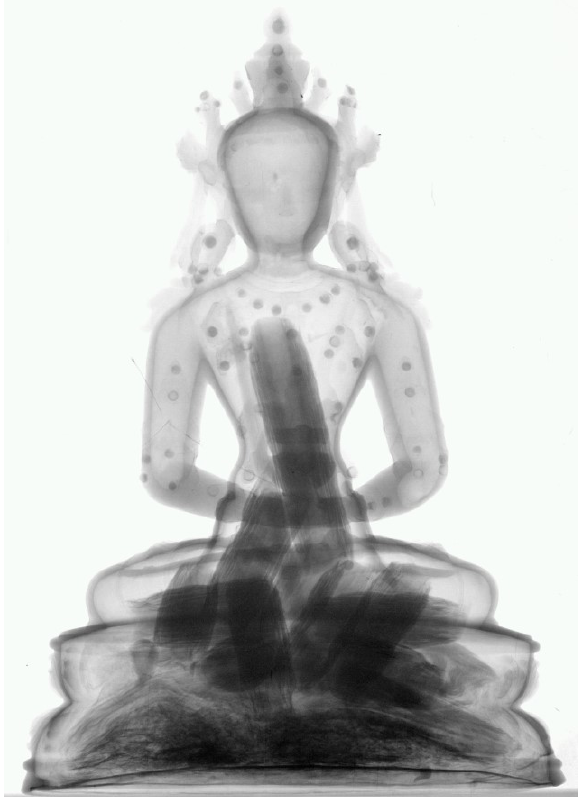
Fig. 5. Example for cultural heritage studies: neutron image of a Tibetan Buddha from the 15 th century, showing the filling with scrolls